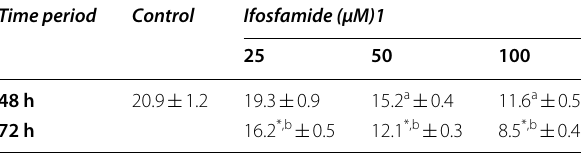
Table 9 Effects of ifosfamide on ATP level in HepG2